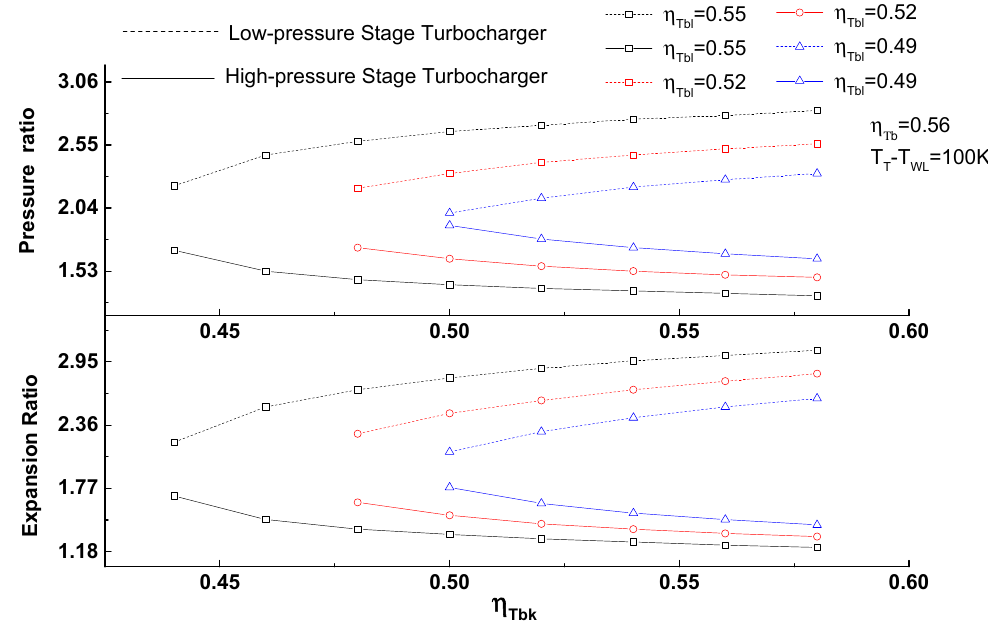
Figure 5. E ff ect of high-pressure stage turbocharger e ffi ciency on two-stage pressure ratio and Figure 5. Effect of high-pressure stage turbocharger efficiency on two-stage pressure ratio and expansion expansion ratio.